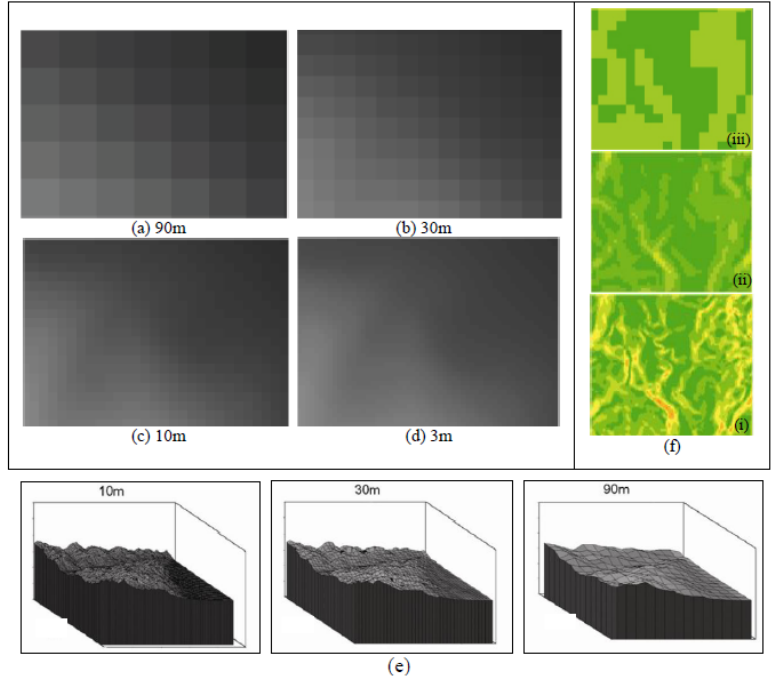
Figure 17. Differences in detail representation due to representation of DEM at different spatial resolutions ( a )–( d ); ( e ) depicts the represented detail at 10 m, 30 m and 90 m, and ( f ) represents the corresponding slope details from (i) 10 m; (ii) 30 m and (iii) 90 m